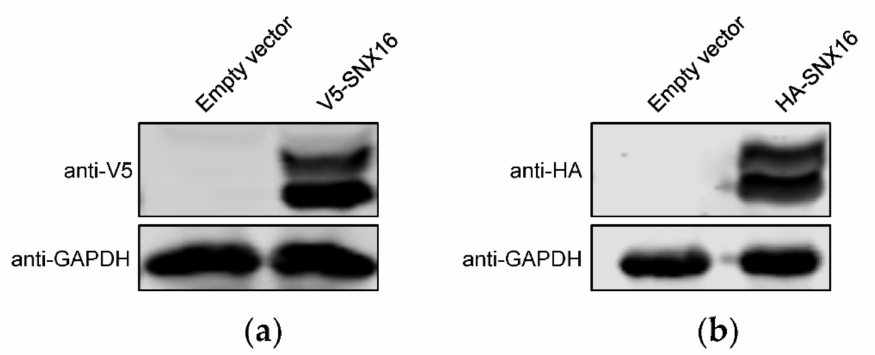
Figure 3. SNX16 is expressed as two obvious bands. HEK293T cells were transfected with plasmids ex- pressing V5- ( a ) and HA-tagged ( b ) SNX16, and were subjected to Western blotting with a rabbit anti-V5 pAb and a rabbit anti-HA pAb, respectively. Data are representative of three independent experiments.